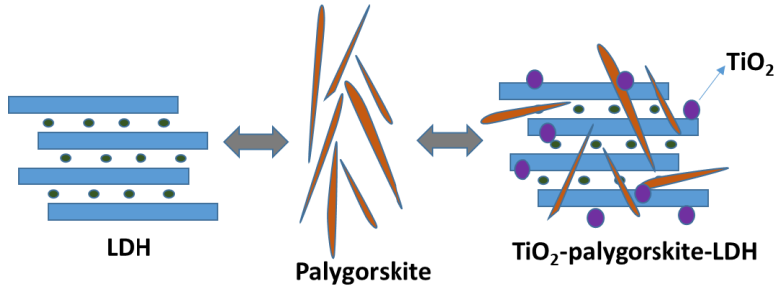
Figure 5. Representation of TiO 2 -palygorskite-LDH nanocomposite formation by sol–gel route.